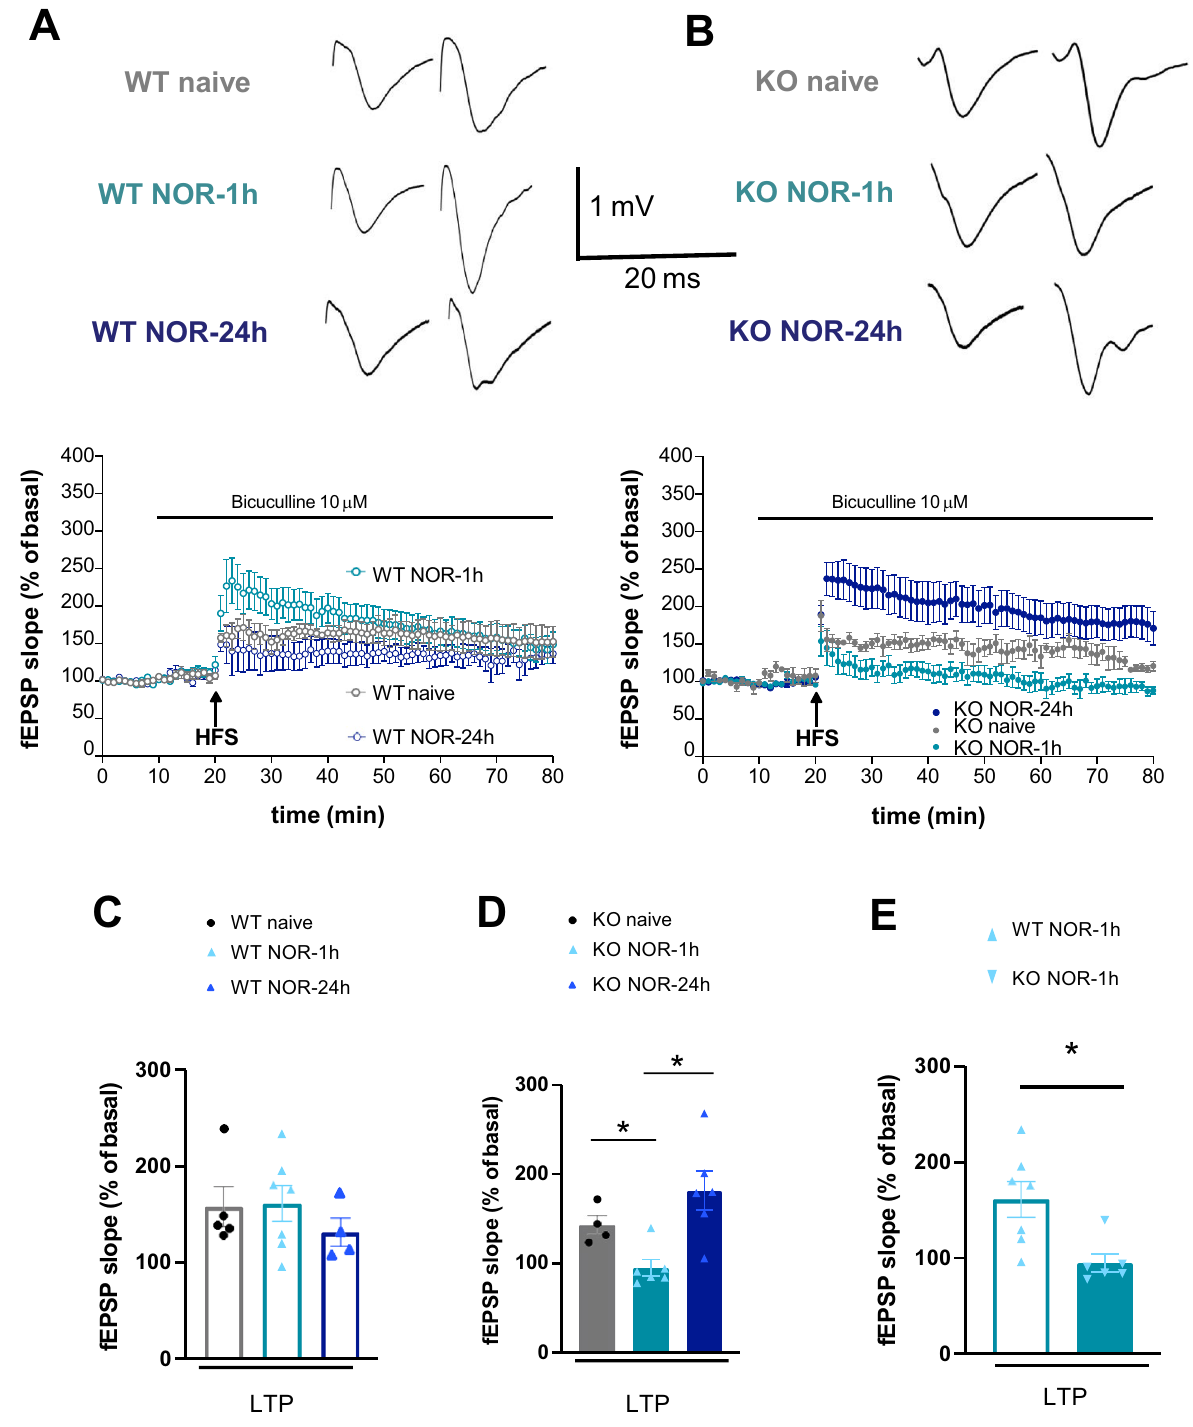
Figure 5. LPP-LTP is occluded in KO mice exposed to NOR-1 h but abnormally elevated in KO mice exposed to NOR-24 h. Data were expressed as mean ± SEM of n experiments (one slice tested per experiment). Slices were obtained from at least two mice for each experimental set. Slope values were normalized, taking the average of the baseline values as 100%. The LTP induction and magnitude were expressed as the mean percentage variation of the slope from baseline calculated in the time windows 0–20 and 40–50 min after HFS, respectively. Synaptic potentiation in WT ( A ) and KO ( B ) mice was measured in different conditions. Upper insets in ( A ) and ( B ) panels show representative fEPSP recordings in the baseline condition (left) and 40 min after LTP induction (right). Calibration bars: 1 mV, 20 ms. ( A ) WT mice show similar potentiation regardless of the training condition. ( B ) In the KO mice, an LTP decrement is found in the NOR-1 h condition (p < 0.05 vs naive, light blue vs grey solid dots; Mann–Whitney test) whereas an exaggerated LTP is found in the NOR-24 h condition (p < 0.01 vs naive, dark blue vs grey solid dots; Mann–Whitney test). ( C–E ) The graphs summarize the LPP-LTP